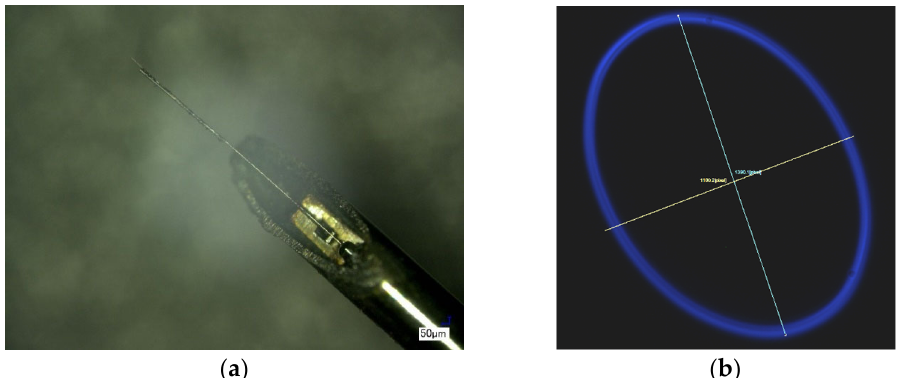
Figure 24. Sample with modified design E actuator configuration: ( a ) cantilever-actuator assembly; ( b ) scan from fiber tip in case asymmetry towards the cold arm. ( b ) scan from fiber tip in case asymmetry towards the cold